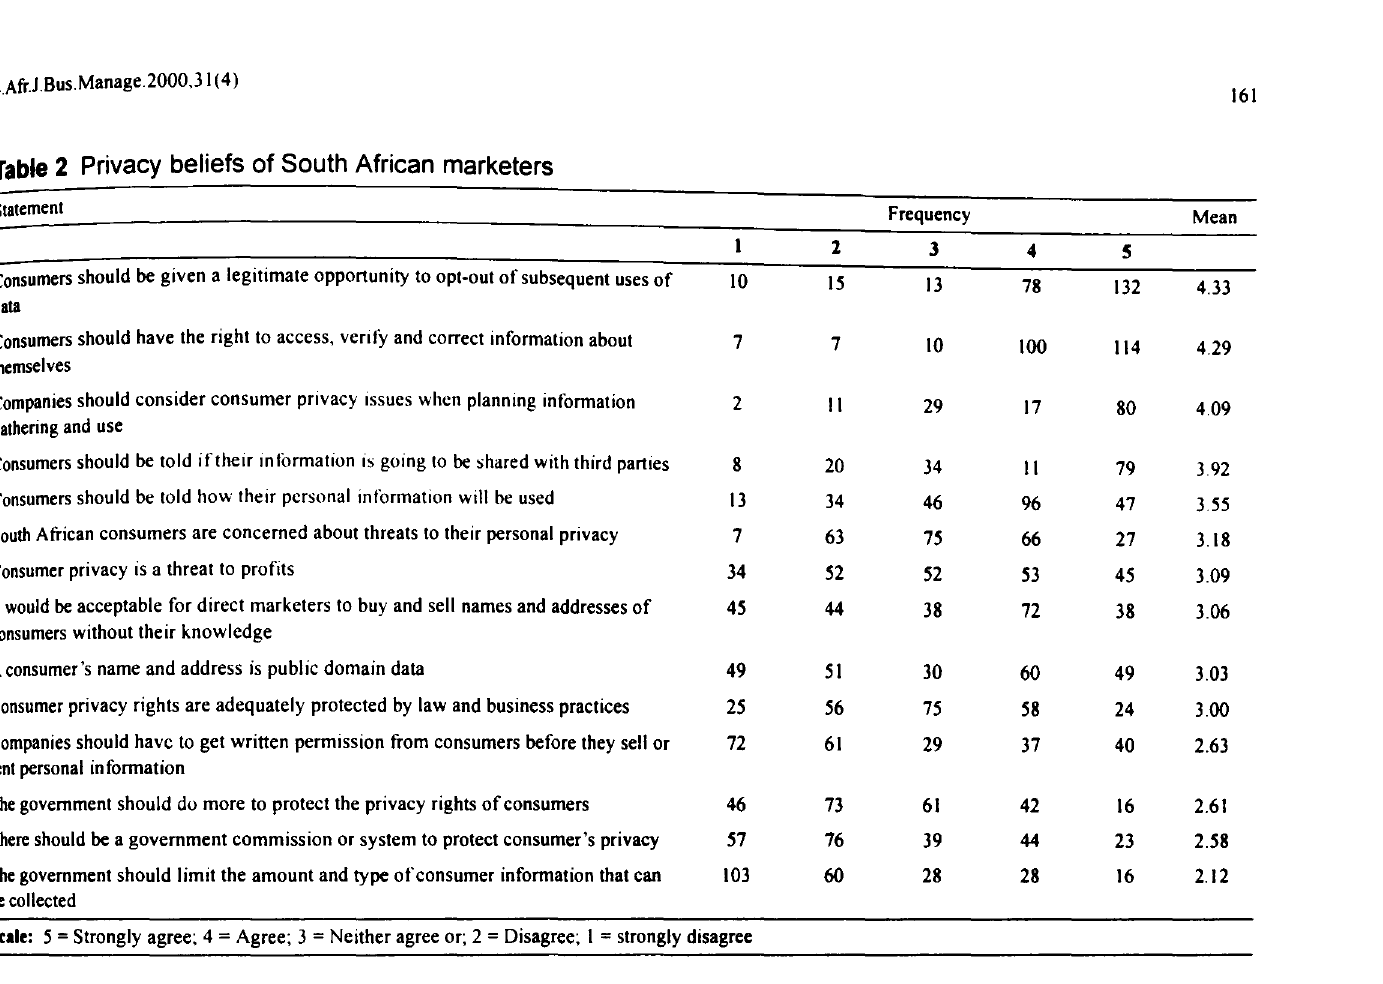
Table 2 Privacy beliefs of South African